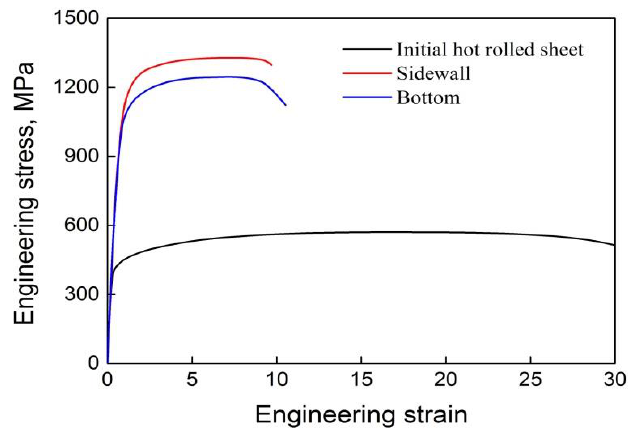
Figure 12. Stress–strain curves of the initial sheet and the thermoformed U-shaped Figure 12. Stress – strain curves of the initial sheet and the thermoformed U-shaped part. Table 3. Tensile properties of the initial sheet and the thermoformed U-shaped part. State or Sampling Posi-